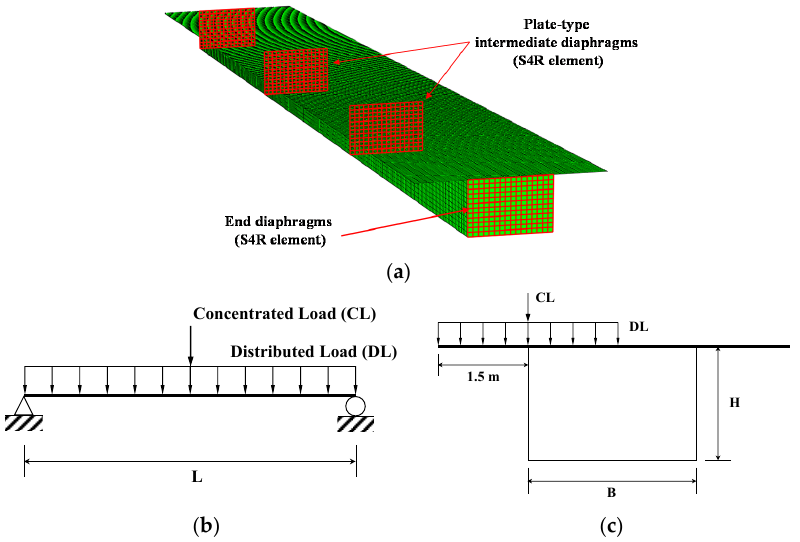
Figure 2. FEA model: ( a ) example of the FEA model, ( b ) load and boundary conditions, and ( c ) locations of the applied live